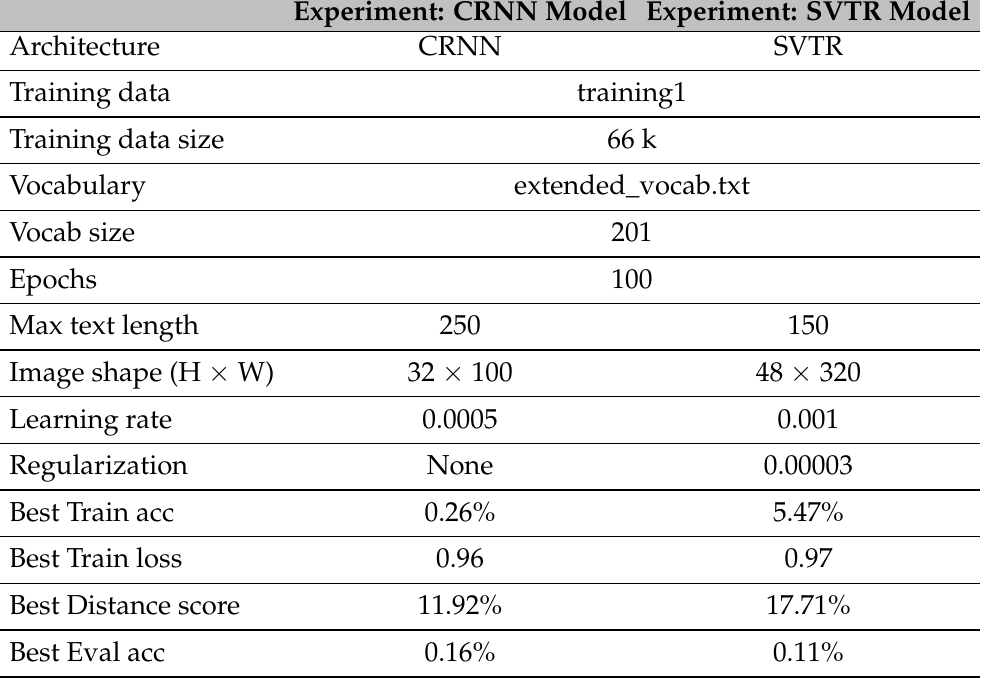
Table 6. English and Hungarian